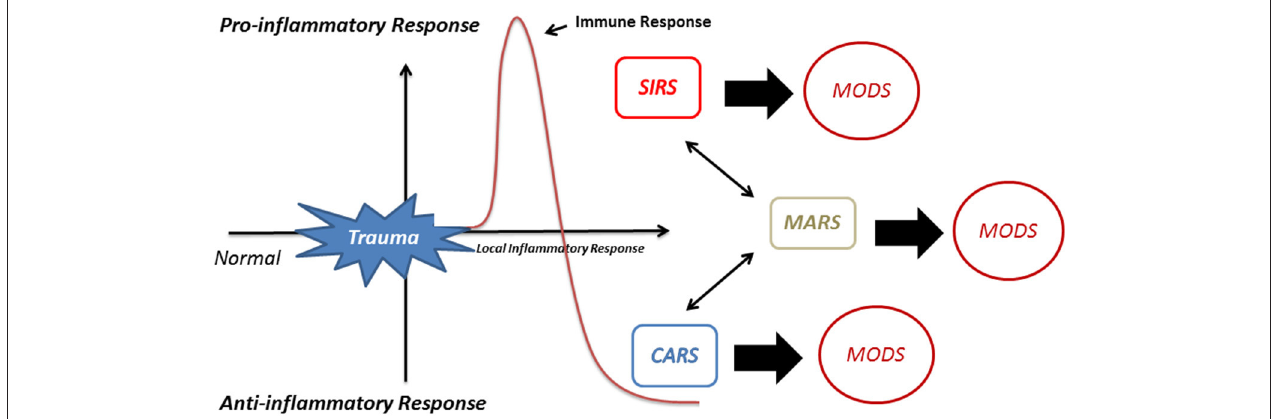
FIGURE 3 | Activation of immune response after trauma. Activation of neutrophils after trauma evokes the development of a local inflammatory response. If this local inflammatory response becomes excessive this may lead to a systemic inflammatory response (SIRS) and multiple organ dysfunction syndrome (MODS). To restore the equilibrium to a favorable state, a compensatory anti-inflammatory response (CARS) may occur or, alternatively, the pro-inflammatory and anti-inflammatory responses may counteract leading to a mixed antagonist response (MARS).